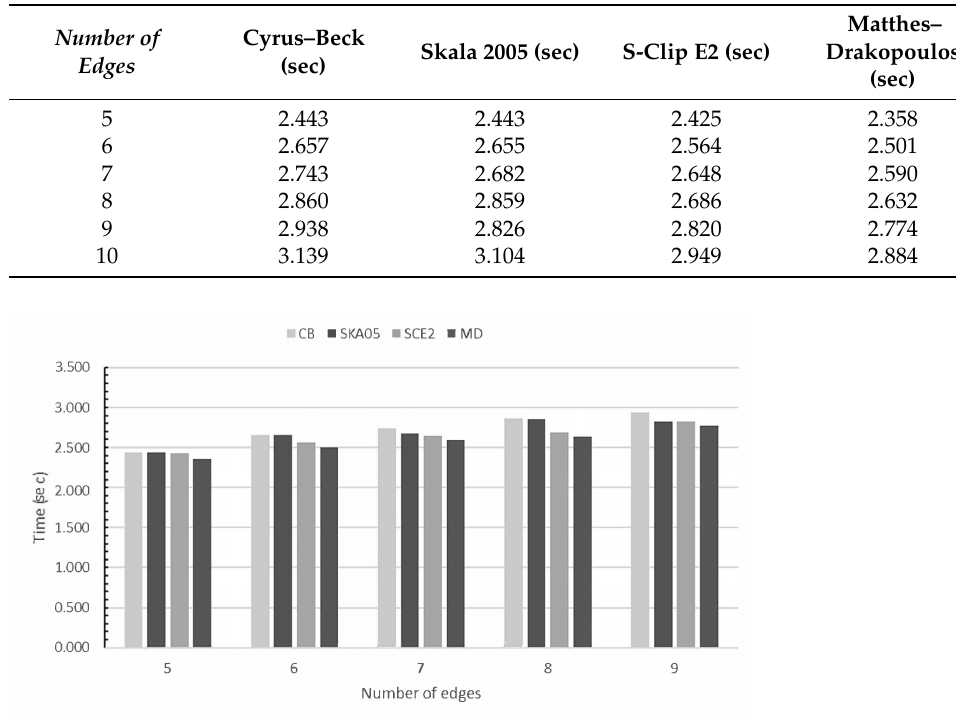
Figure 44. Average time of each algorithm when clipping 10 million lines against convex polygons with different number of edges (lower is